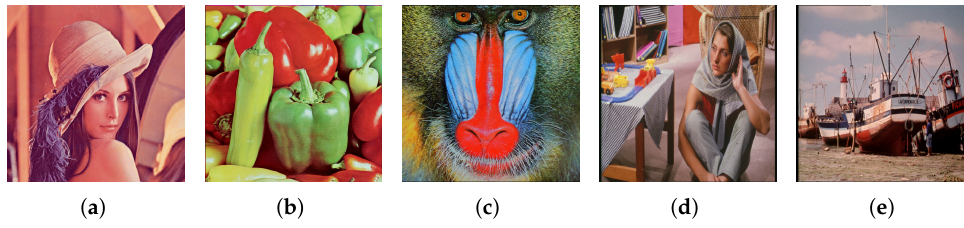
Figure 12. Five test images with same size 512 × 512 × 3. ( a ) Lena. ( b ) Peppers. ( c ) Baboon. ( d ) Barbara. ( e )